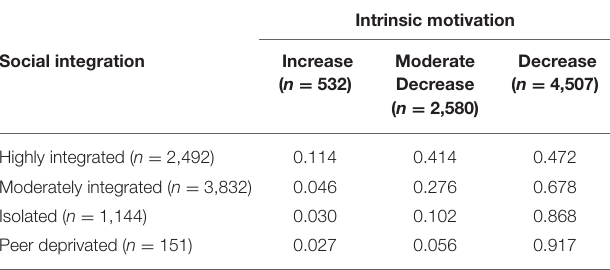
TABLE 5 | Latent transition probabilities based on the estimated